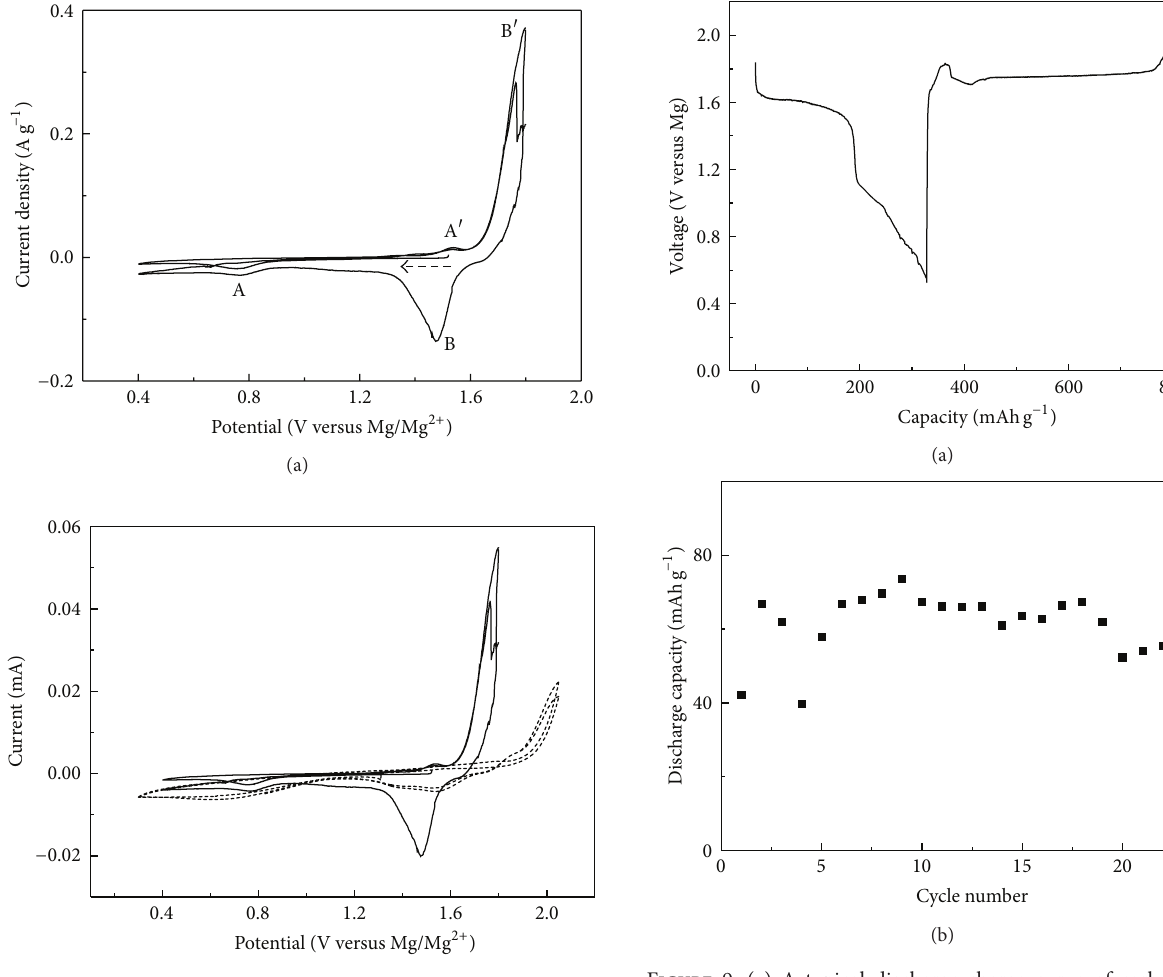
Figure 9: (a) A typical discharge-charge curve of carbyne poly- sulfide in a two-electrode coin cell employing magnesium metal as the counter electrode at a current rate of 3.9 mAg −1 . (b) The discharge capacity versus cycle number of carbyne polysulfide in a two-electrode coin cell employing magnesium metal as the counter electrode at a current rate of 5.4 mAg −1